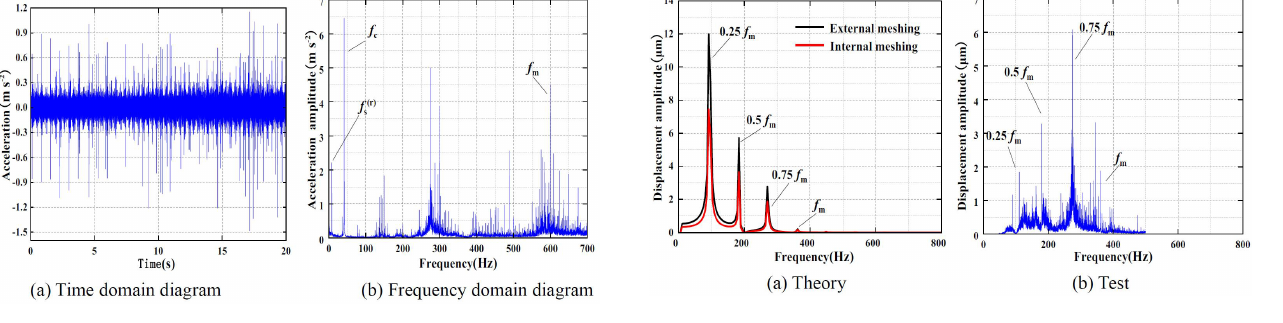
Figure 15. Frequency domain diagram of the vibration displace- ment at n = 1500rpm.